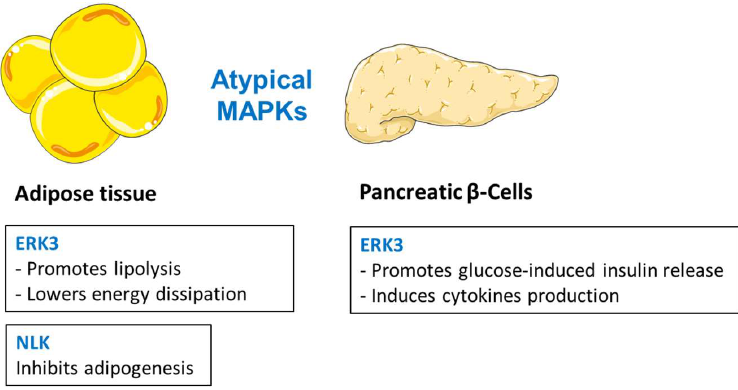
Figure 5. The role of atypical MAPKs in regulation of metabolism.